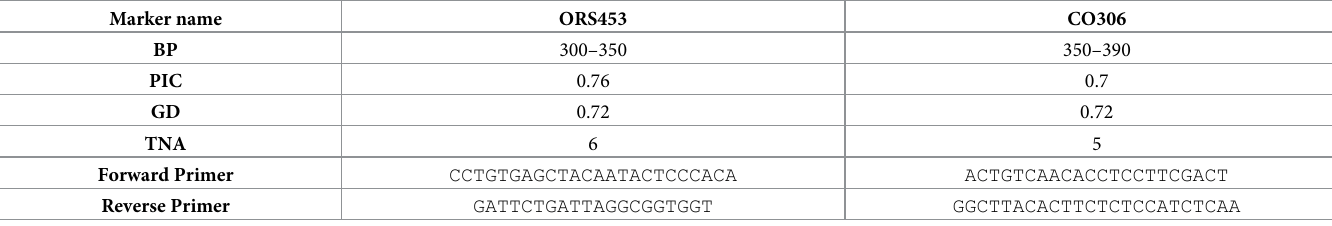
Table 1. Scorable DNA bands amplified by polymorphic SSR primers through